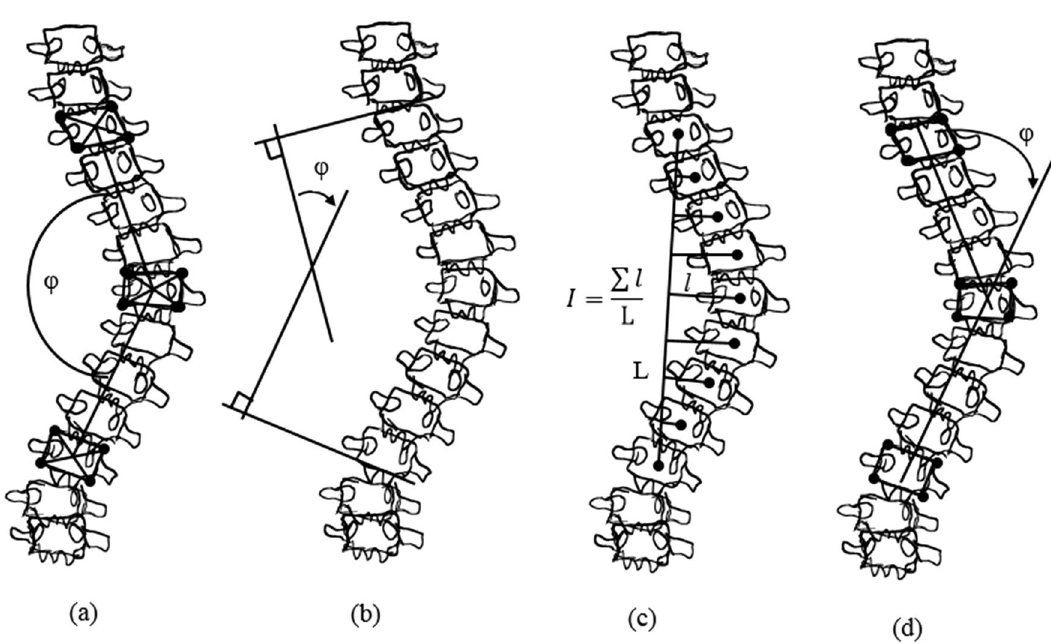
Figure 1. Scoliosis views: ( a ) normal versus scoliotic spine. ( b ) Definition of required anatomical landmarks. ( c ) Definition: medial axis (MA), central sacral line (CSL) 7 .